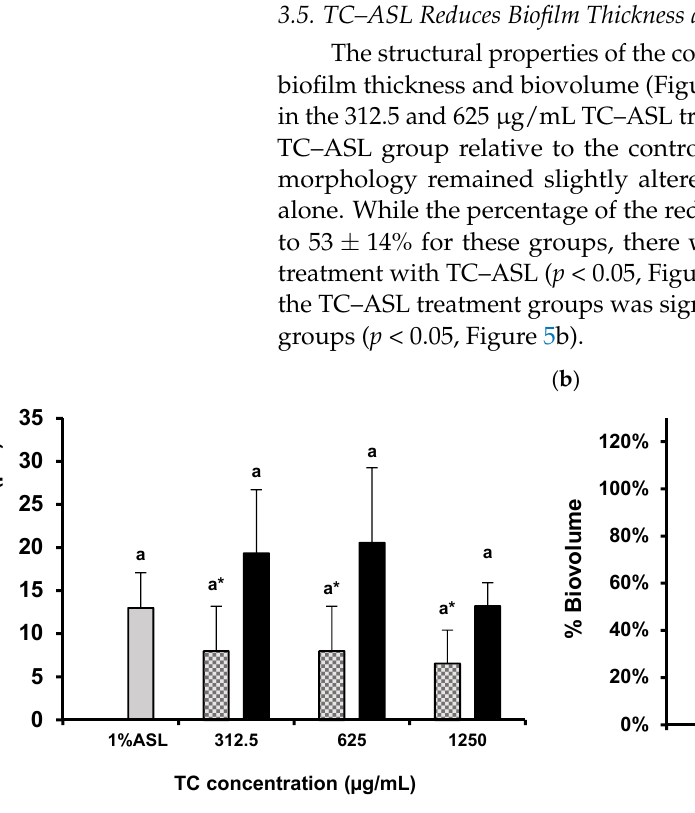
Figure 5. Quantification of ( a ) biofilm thickness or ( b ) biofilm volume after treatment with TC–ASL, TC, and 1% ASL. The biofilm thickness was obtained from the z-stacks while the volume of treated biofilm was expressed relative to the control (sterile-water-treated biofilm)(100%). The results represent the average of three independent experiments ± SD. Different letters denote a statistically significant difference ( p ≤ 0.05) between different treatment groups while the same letters show no statistical difference ( p > 0.05) between different treatment groups, including the within-group comparison and between-group comparison. * Denotes a significant difference compared to the control ( p ≤ 0.05).